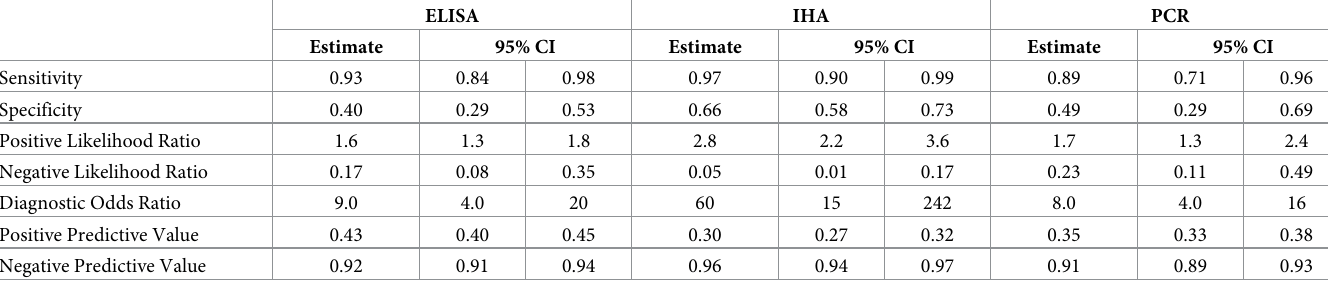
Table 3. Summary estimates of diagnostic accuracy for S . japonicum (stool examination as a reference standard). ELISA IHA